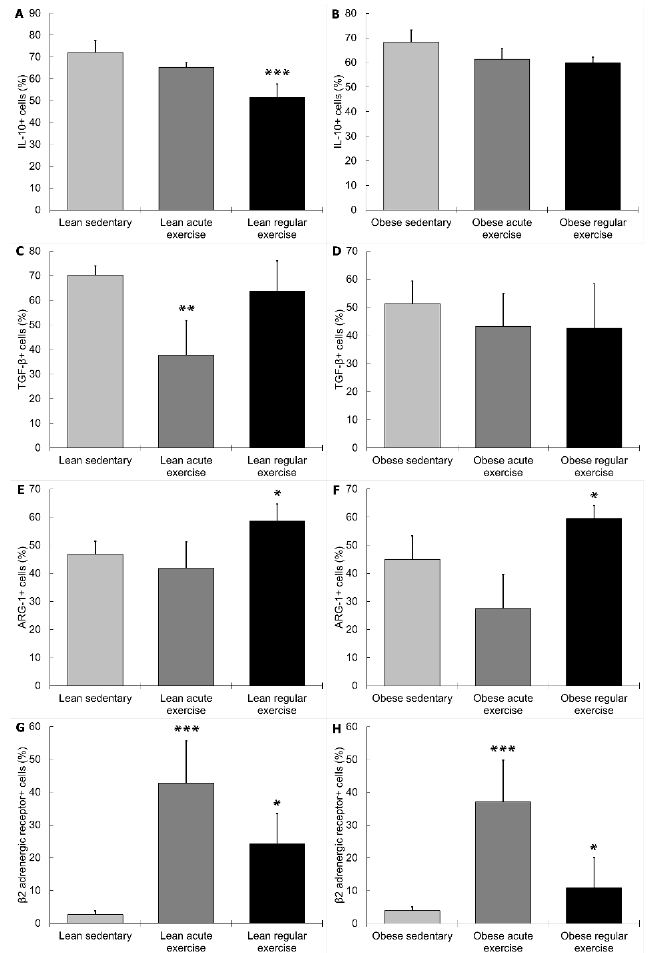
Figure 3. Effect of exercise on monocytes expressing anti-inflammatory cytokines (IL-10 and TGF- β ), anti-inflammatory phenotype (arginase-1 (ARG-1)), and β 2 adrenergic receptors in lean (sedentary